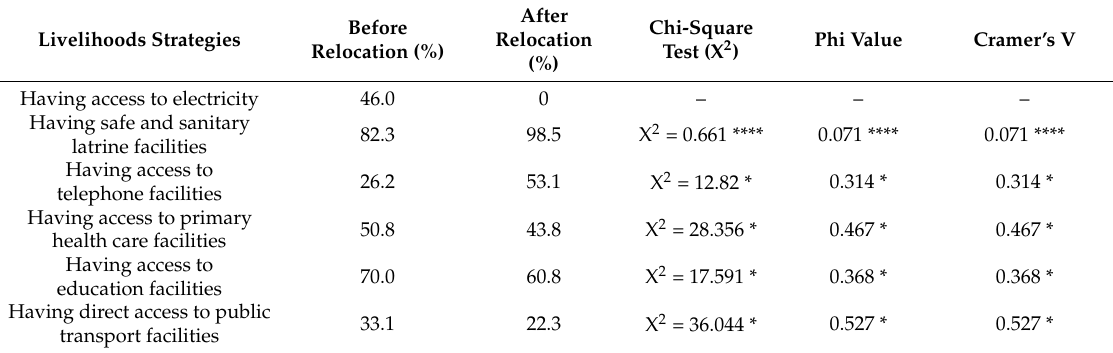
Table 8. Strategies related to social life and security before and after relocation.